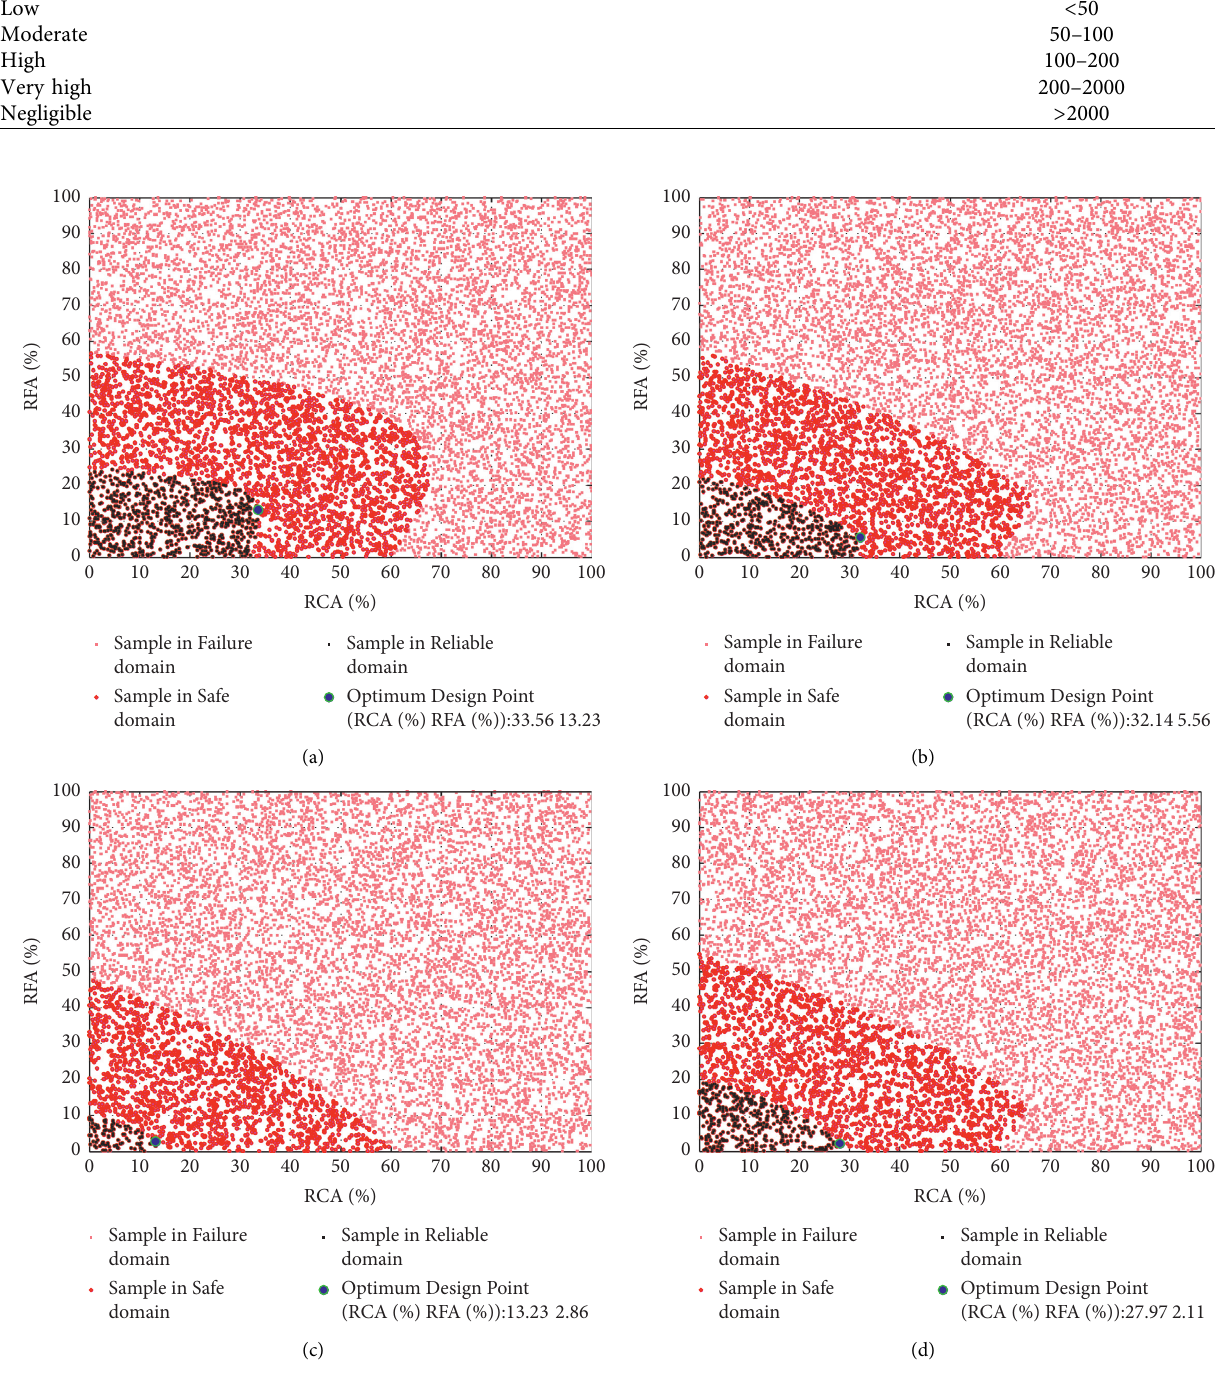
Figure 21: WSM RBDO result for different environment condition. (a) T � 23 ℃ , rh � 70%, C rh � 70%, C cl − � 5%, ρ thr � 100 Ω .m . (c) T � 23 ℃ , rh � 70%, C cl − � 8%, ρ thr � 100 Ω .m . (d) T � 23 ℃ , rh � 70%, C cl − � 10%, ρ thr � 80 Ω .m